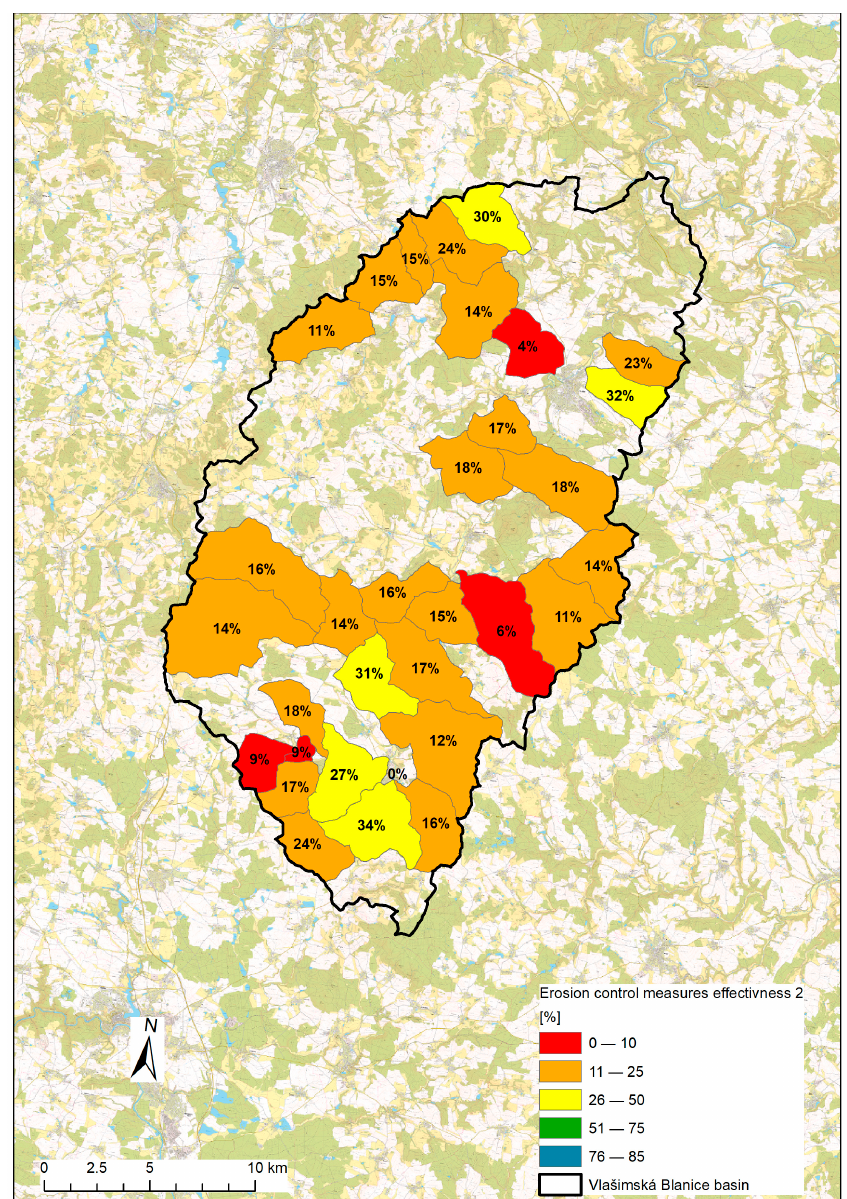
Figure 6. Assessment of erosion control measures of effectiveness 2 in terms of the soil loss from agricultural land. agricultural